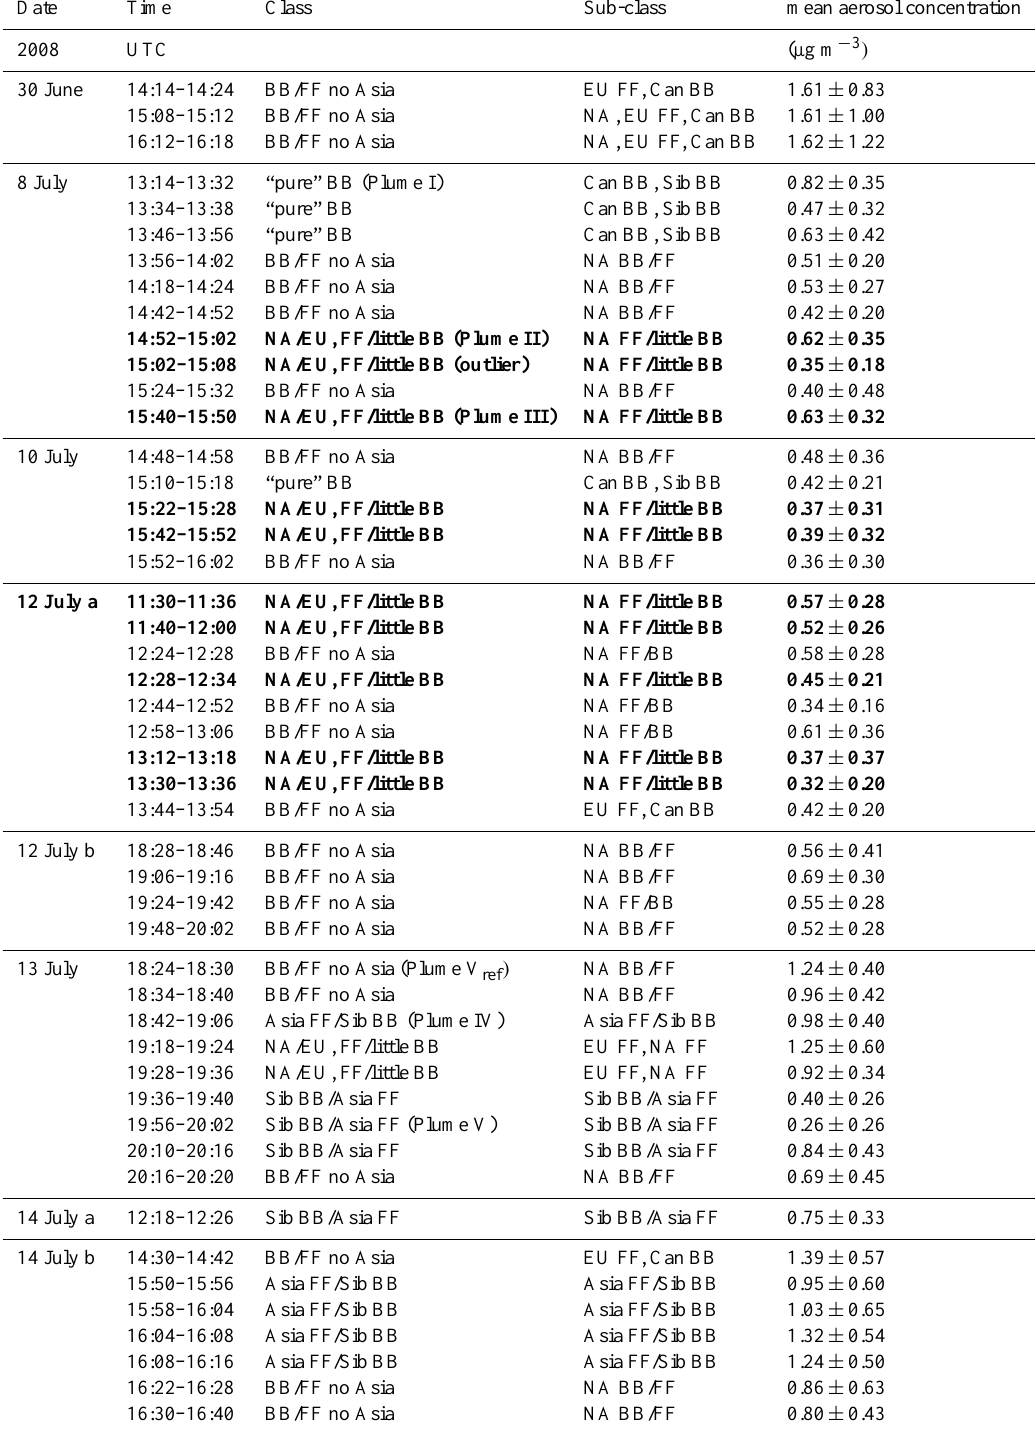
Table 3. List of all 48 identified pollution plumes. The highlighted plumes were used for the aerosol lifetime calculation (see Fig.